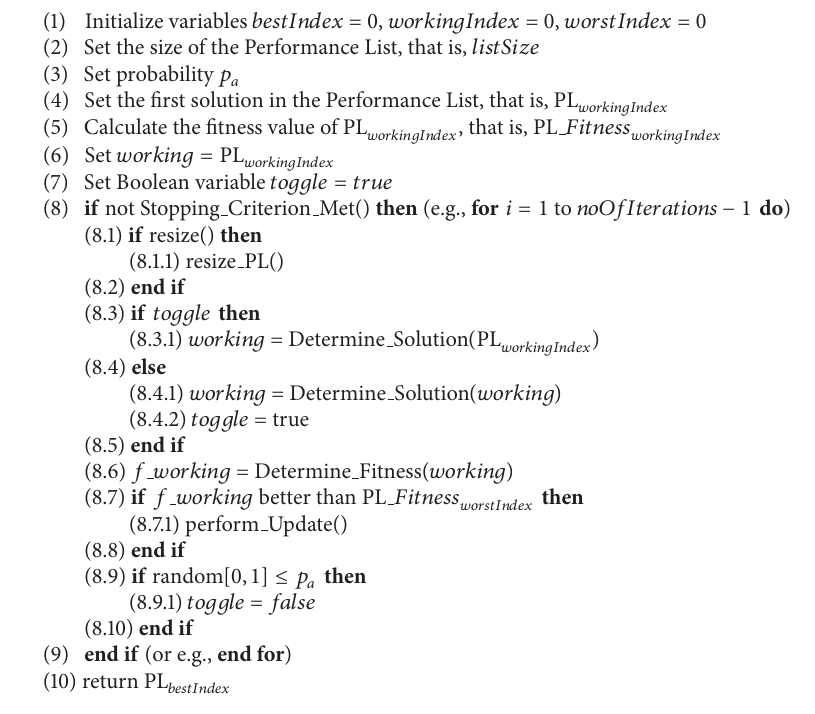
Algorithm 1: The enhanced Best Performance